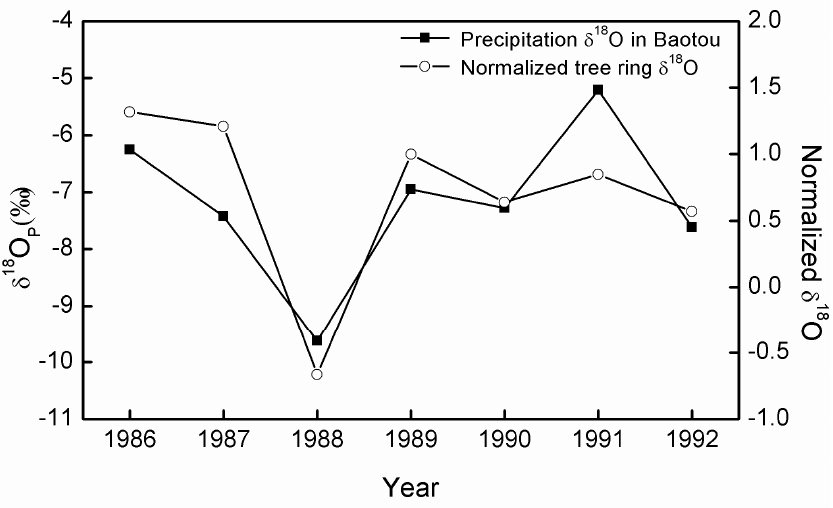
Figure 12. Comparison between tree-ring δ 18 O of Heng Mountain and precipitation δ 18 O from June to July in Baotou.